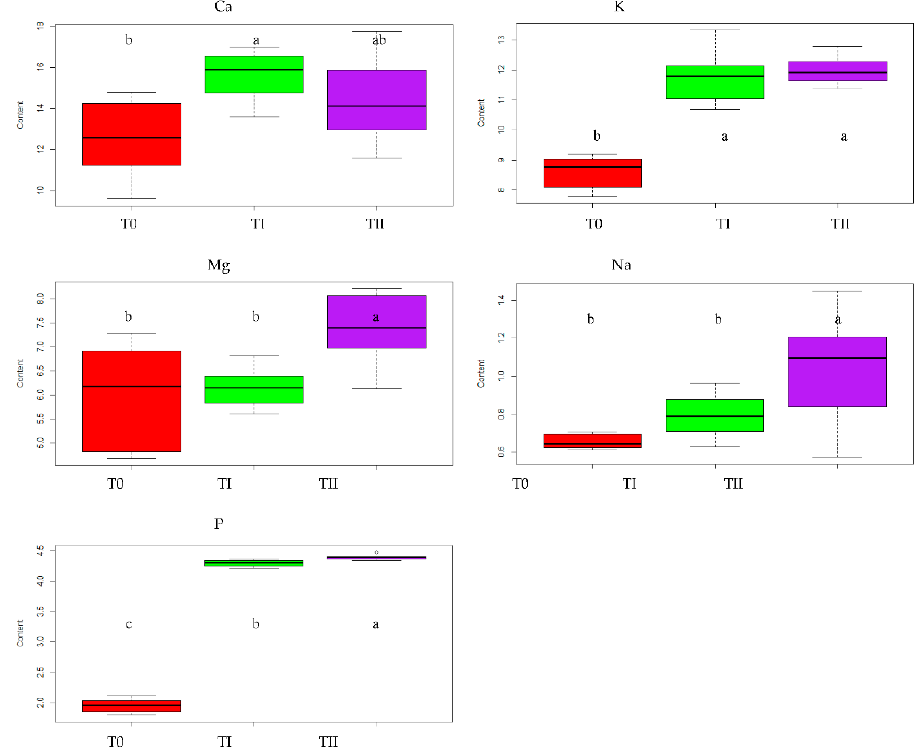
Table 2. p -values from one-way ANOVA determined separately for each macronutrient in lupine and oat. Comparison between T0—control soil, TI—soil with compost addition and TII—soil with FA addition.